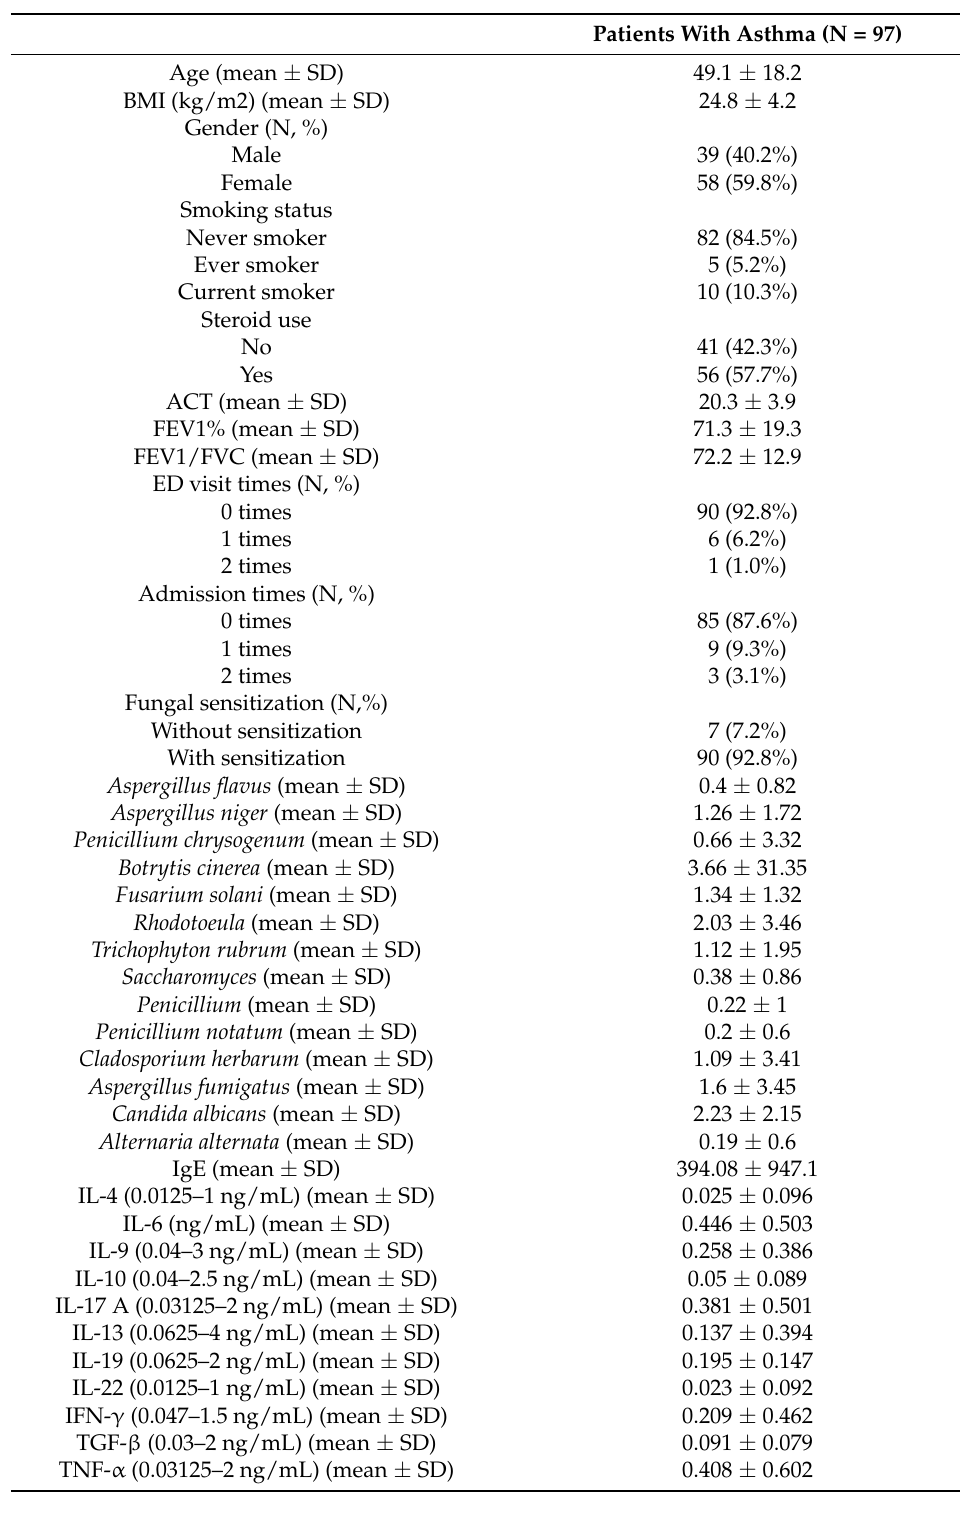
Table 1. Clinical features of patients with